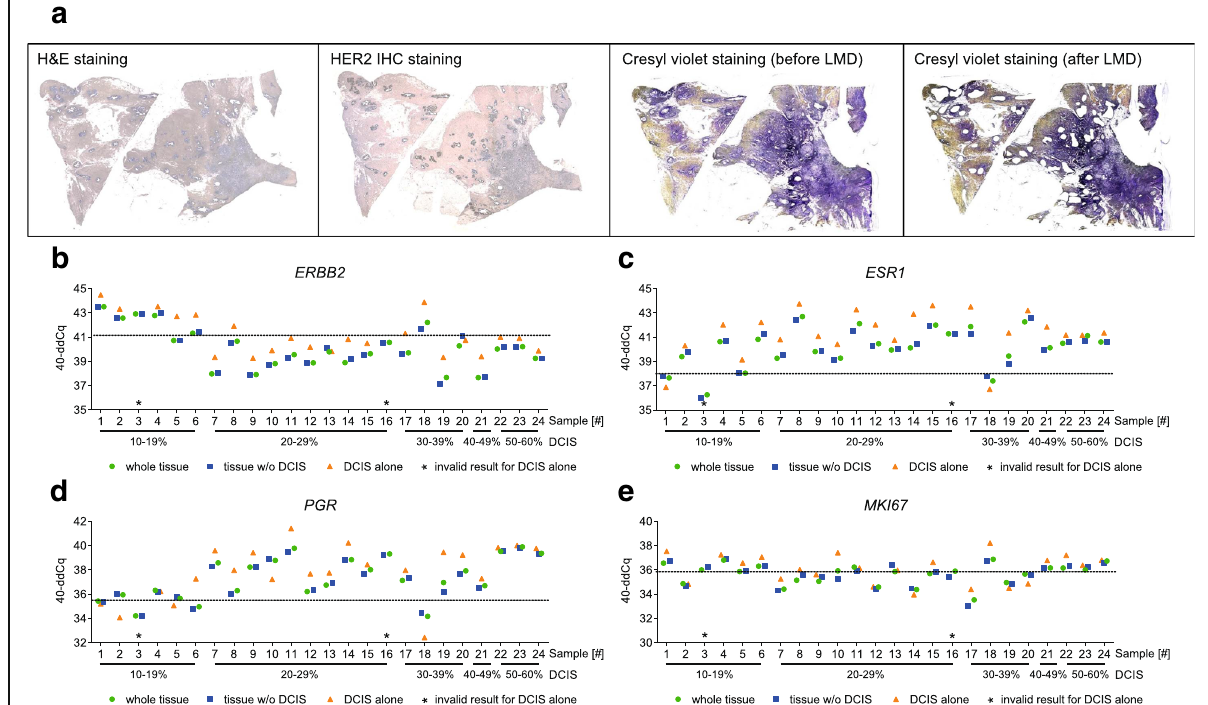
Fig. 4 Effect of DCIS on relative gene expression. a Representative images (sample 17) of H&E stained, HER2 immunostained and cresyl violet stained sections before and after microdissection of DCIS-only areas. b - e Shown in the graph are gene expression data for n = 24 breast cancer specimen for ERBB2 ( b ), ESR1 ( c ), PGR ( d ) and MKI67 ( e ) of paired whole tissue sections (green circles), whole tissue sections without DCIS (blue squares) and DCIS-enriched (orange triangles) microdissected tissue. Dotted lines represent the respective cut-off for the four marker genes. ( ERBB2 : 41.10; ESR1 : 38.00; PGR : 35.50; MKI67 :